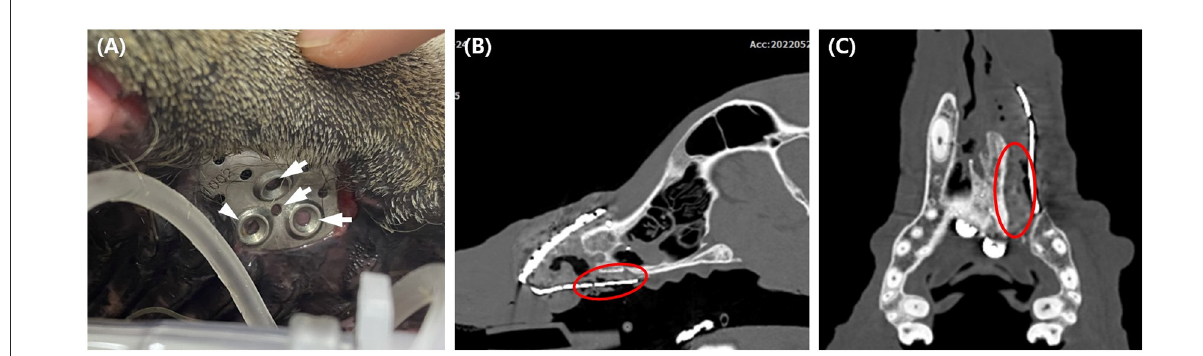
FIGURE7 Six months postoperative evaluation of the implant exposure. Note the pink soft tissue under the implant hole (arrow), and the pigmented tissue suggesting palatal epithelium under one hole (arrowhead) (A) . CT taken 6 months after surgery revealed soft tissue formation presumed to be palate mucoperiosteum (red circle) (B,C)